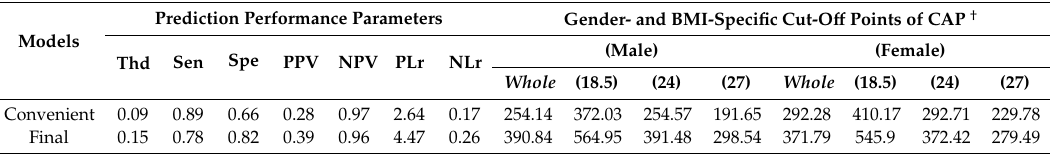
Table 4. Optimal Youden index-based cut-o ff points and the associated screening performance index by classification models.